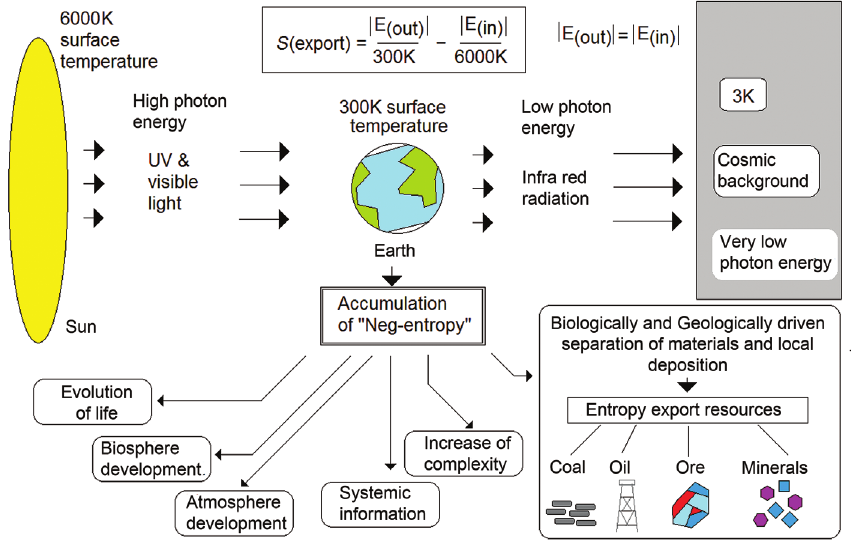
Figure 4 The earth as a global entropy export system: energy flow and the role of accumulation of neg-entropy in living systems and deposited